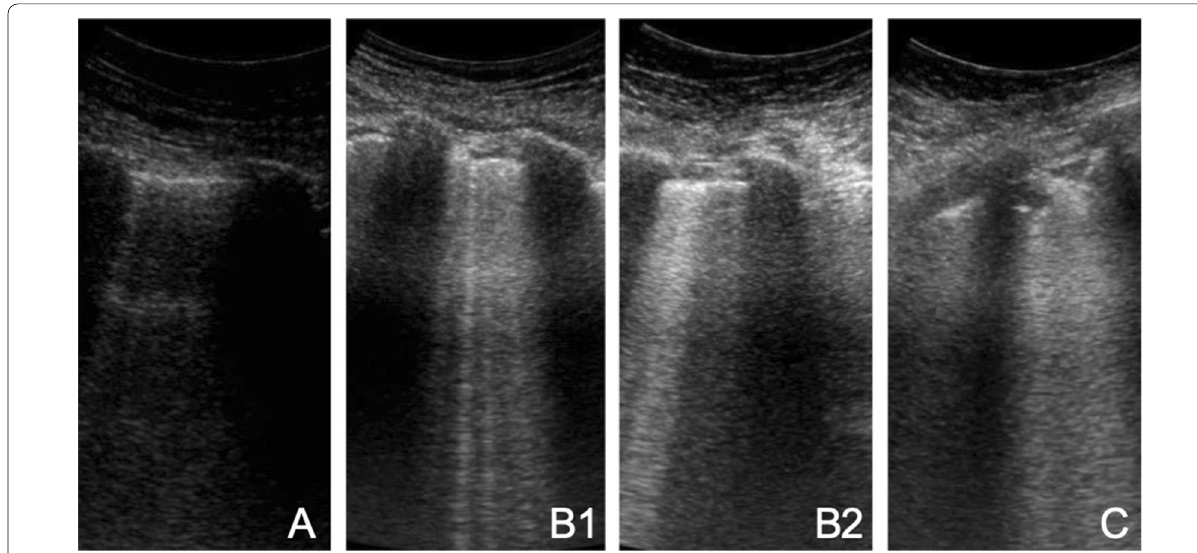
Fig. 1 Common Lung Ultrasound patterns in COVID-19 patients. From left to right: ( a, b1, b2, c )